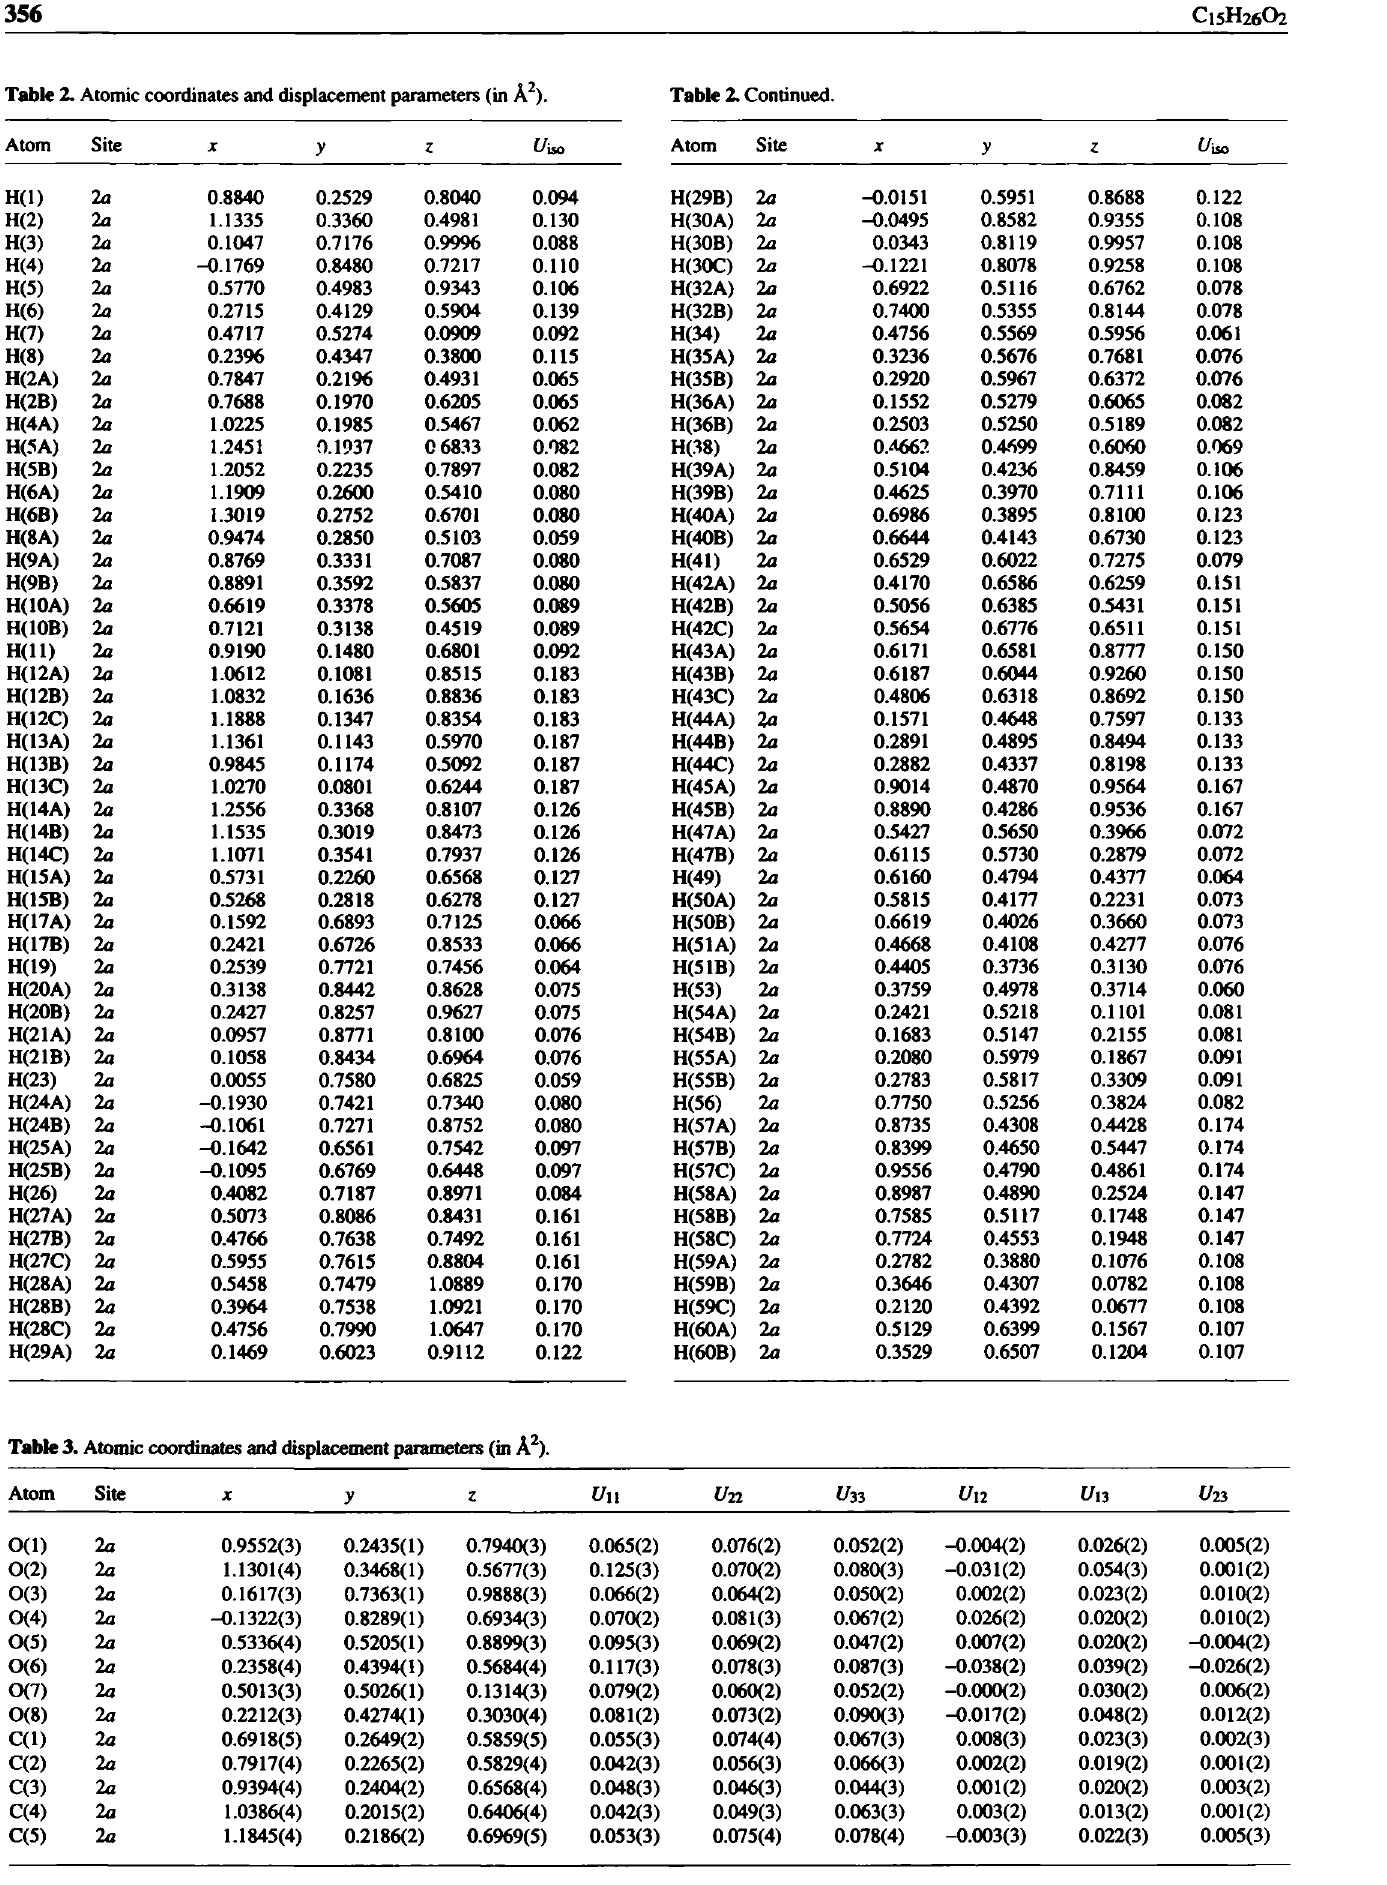
Table 3. Atomic coordinates and displacement parameters (in A 2